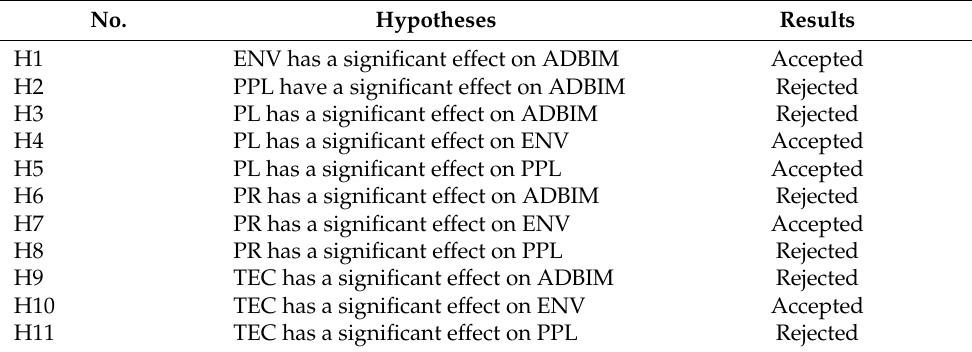
Table 14. Hypotheses